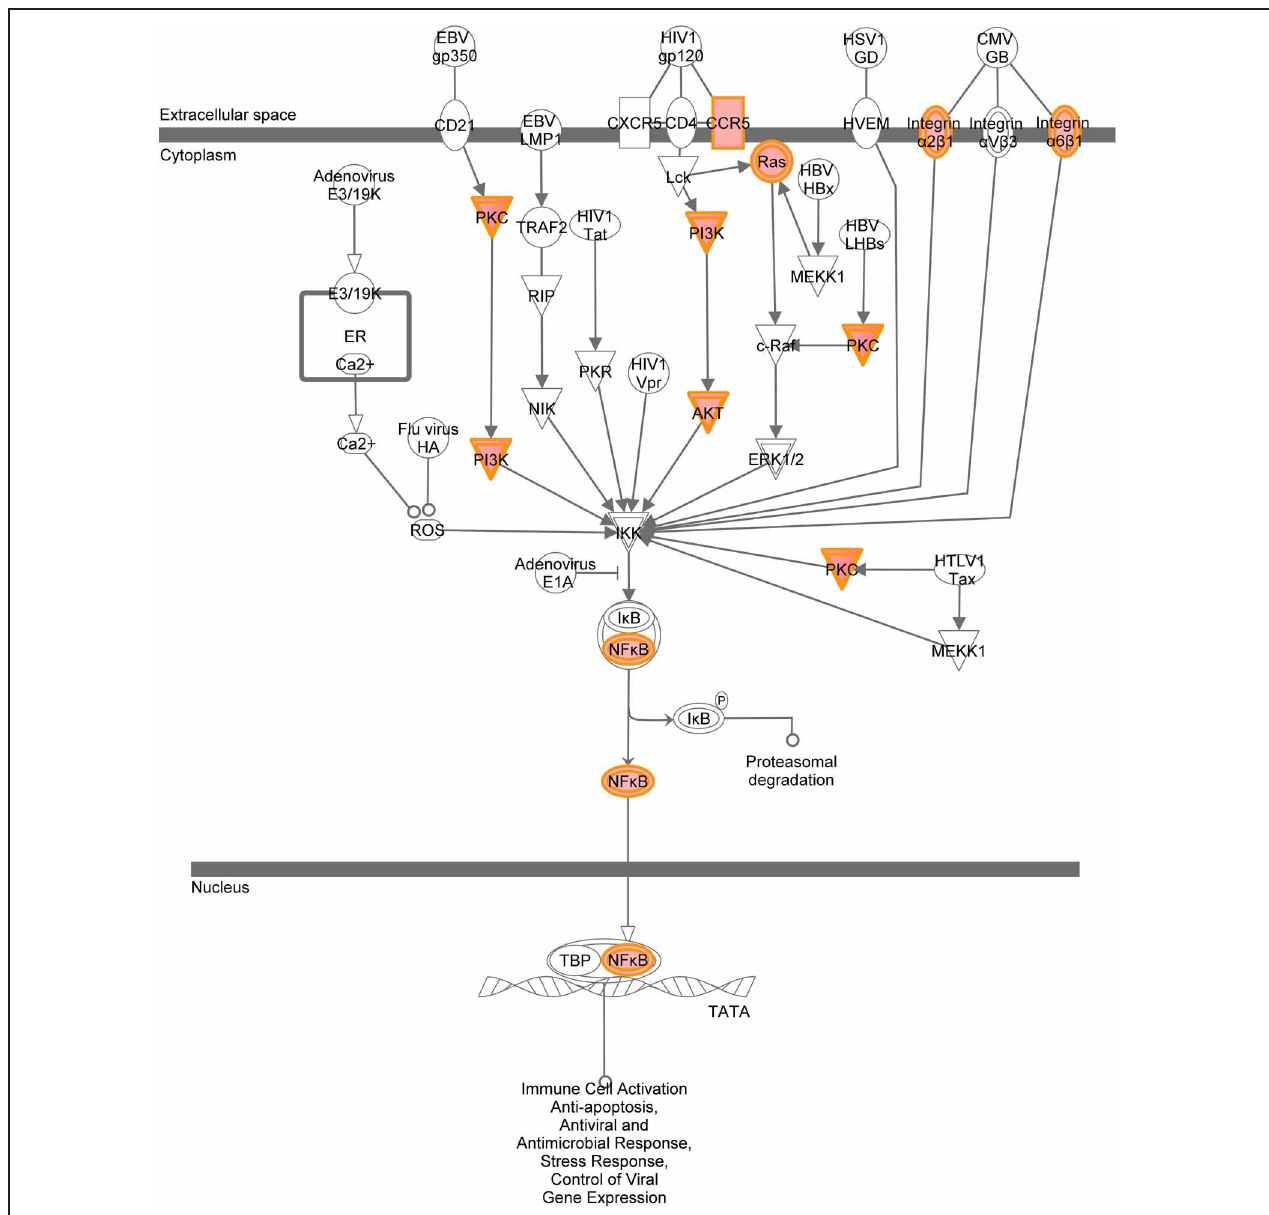
FIGURE A2 | NF- κ B activation by